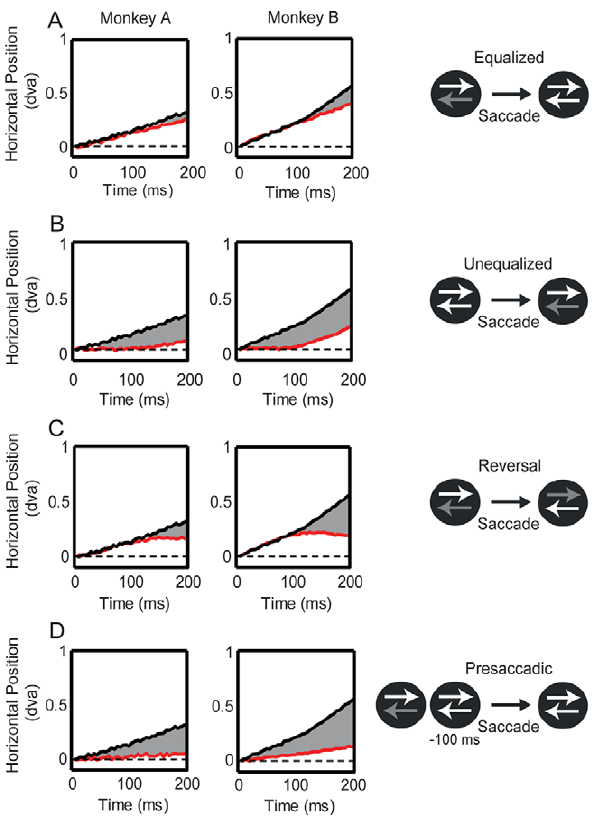
Figure 6. Quantifying the timing of smooth eye movement planning. The figure depicts the eye movements of Monkey A (left column) and Monkey B (middle column) over 200 ms starting at the end of the saccade. The black line in each panel shows the average eye position relative to saccade endpoint in the Standard condition, in which two patterns were present (0.2% and 100% RMS-contrast) throughout the trial. The red line in each panel shows the average eye position under the stimulus manipulation that was applied in that condition (depicted in the right column). Shading indicates the time points at which there was a significant deviation from the Standard condition. A. In the Equalized contrast condition (red line), unequal contrasts were equalized during the saccade. The effect of the initial contrast difference persisted for approximately 150 ms (Monkey A: 165 ms; Monkey B: 130 ms). B. In the Unequalized contrast condition, the two patterns began at 100% RMS-contrast and at saccade onset, one pattern was decreased to 0.2% RMS-contrast. The effect of differentiating contrast took 130 ms to emerge (Monkey A: 150 ms; Monkey B: 110 ms). C. In the Reversal condition, the two patterns began at 0.2% and 100% RMS-contrast, and contrasts were reversed upon saccade onset. Smooth eye movements followed the original higher contrast pattern for 130 ms (Monkey A: 140 ms; Monkey B: 120 ms) before the initial bias was weakened D. In the Presaccadic condition, the two patterns started out at 0.2% and 100% RMS-contrast, but 100 ms prior to removal of the fixation point, the lower contrast pattern increased to 100% RMS-contrast. While greatly diminished, smooth eye movements in the direction of the previously